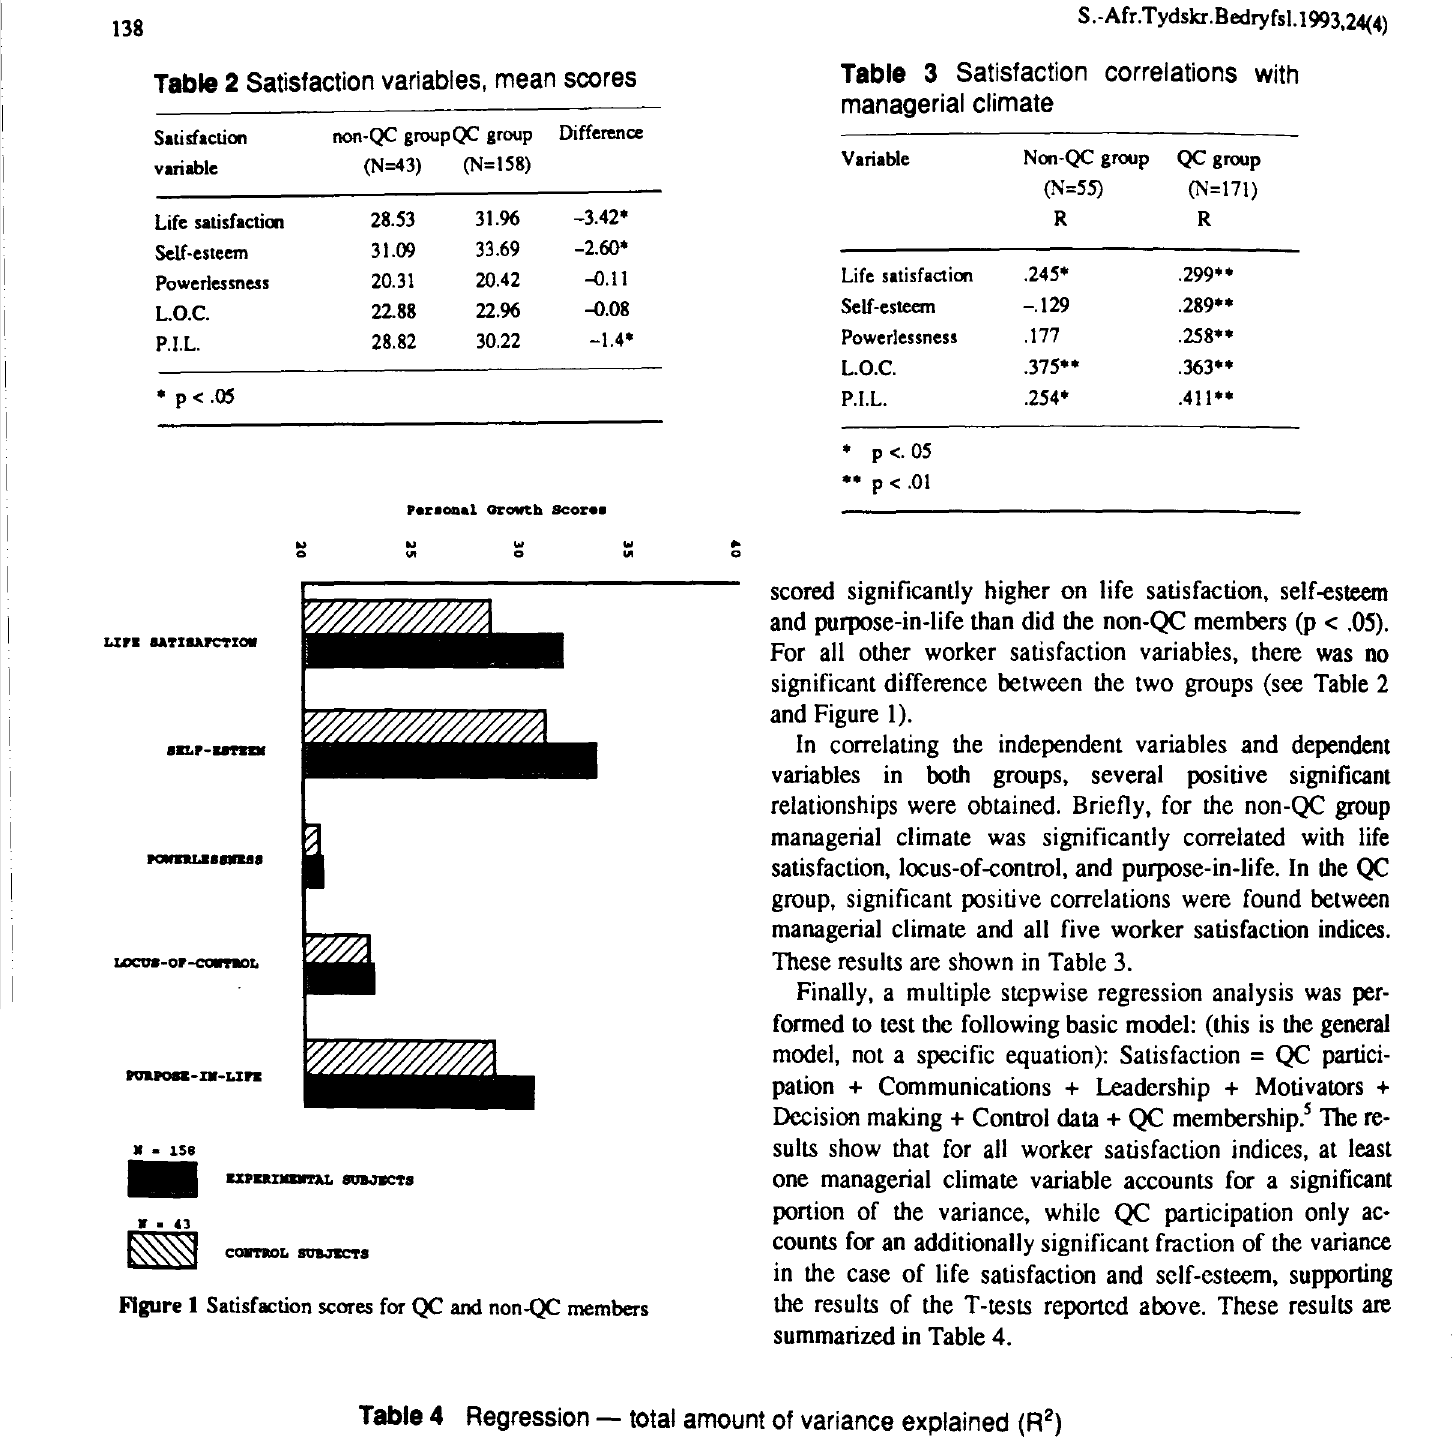
Table4 Regression - total amount of variance explained (R